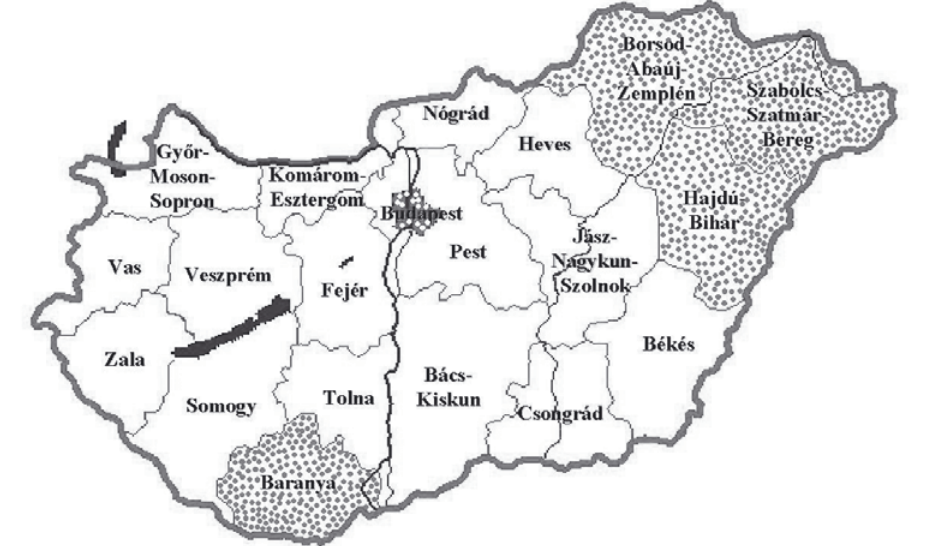
Figure 1. The map of the investigated